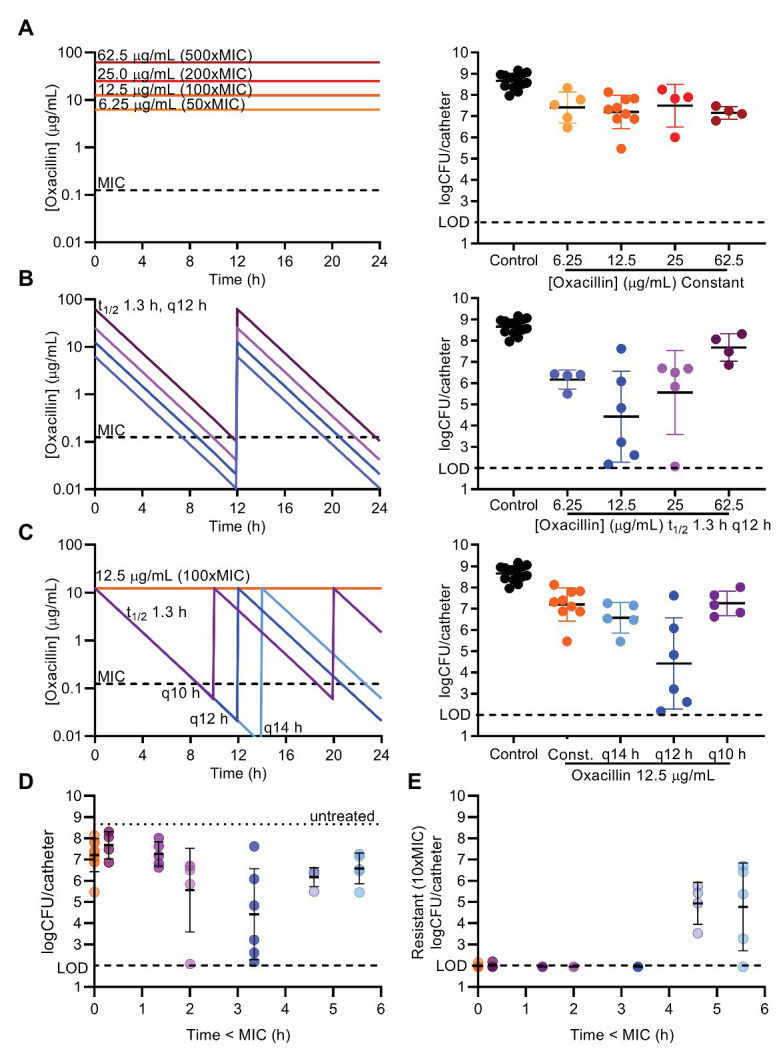
Length of periodic break gives U-shaped dose response curve. Oxacillin was given as constant regimens of 6.25, 12.5, 25, or 62.5 μg/ml (50, 100, 200, or 500x MIC; A) or as periodic regimens with a t1/2 of 1.3 h, and given every (q) 10, 12, or 14 h (B,C) for 7 days. Programmed oxacillin regimens are depicted on the left. Biofilm suspensions were plated on BHI to determine total CFU/catheter after 7 days (right). Untreated controls, 12.5 μg/ml (100xMIC) constant, or 12.5 μg/ml (100x MIC) q12 h are the same data (A–C) visually repeated for purposes of comparison. (D) CFU results for each periodic regimen, and 12.5 μg/ml (100xMIC) constant for comparison, are displayed with the time oxacillin was below the planktonic MIC 0.125 μg/ml (Time < MIC) in the programmed conditions. (E) Biofilm suspensions were plated on agar containing 10xMIC oxacillin to determine resistant CFU, and only those periodic regimens with the greatest Time < MIC allowed resistance expansion above the limit of detection (LOD). Symbols represent mean of three catheters from one experiment. Lines are mean and SD of symbols (repeat experiments). LOD, limit of detection.